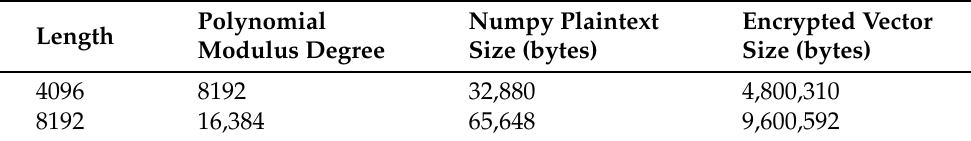
Table 4. Space taken of different length vectors, unencrypted as NumPy arrays and encrypted as ReSeal vectors, including private keys and all meta-data required for